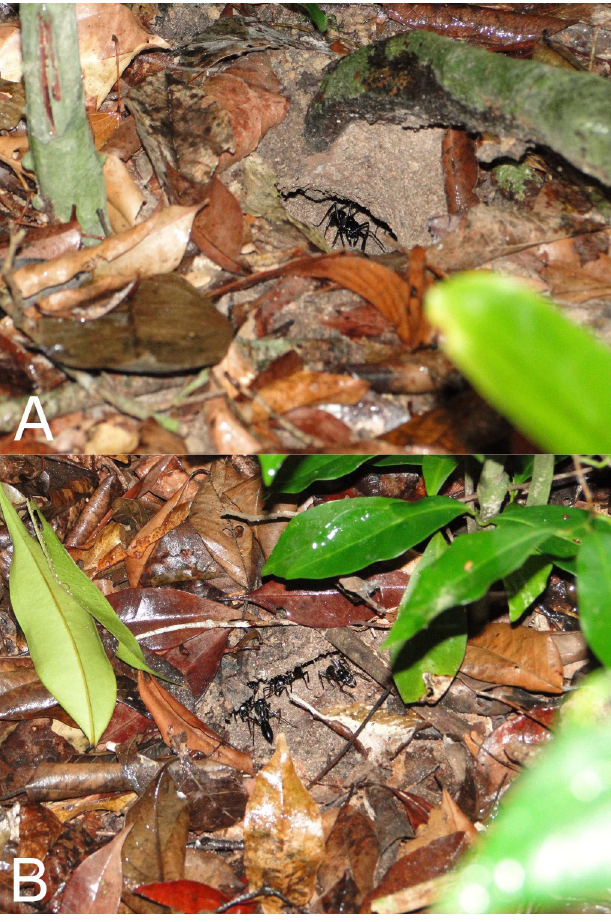
Fig 1 . Dinoponera lucida nest opening at Reserva Natural Vale, state of Espírito Santo, Brazil. (A) Guard activity by a worker-sentinel, (B) workers in nest maintenance after